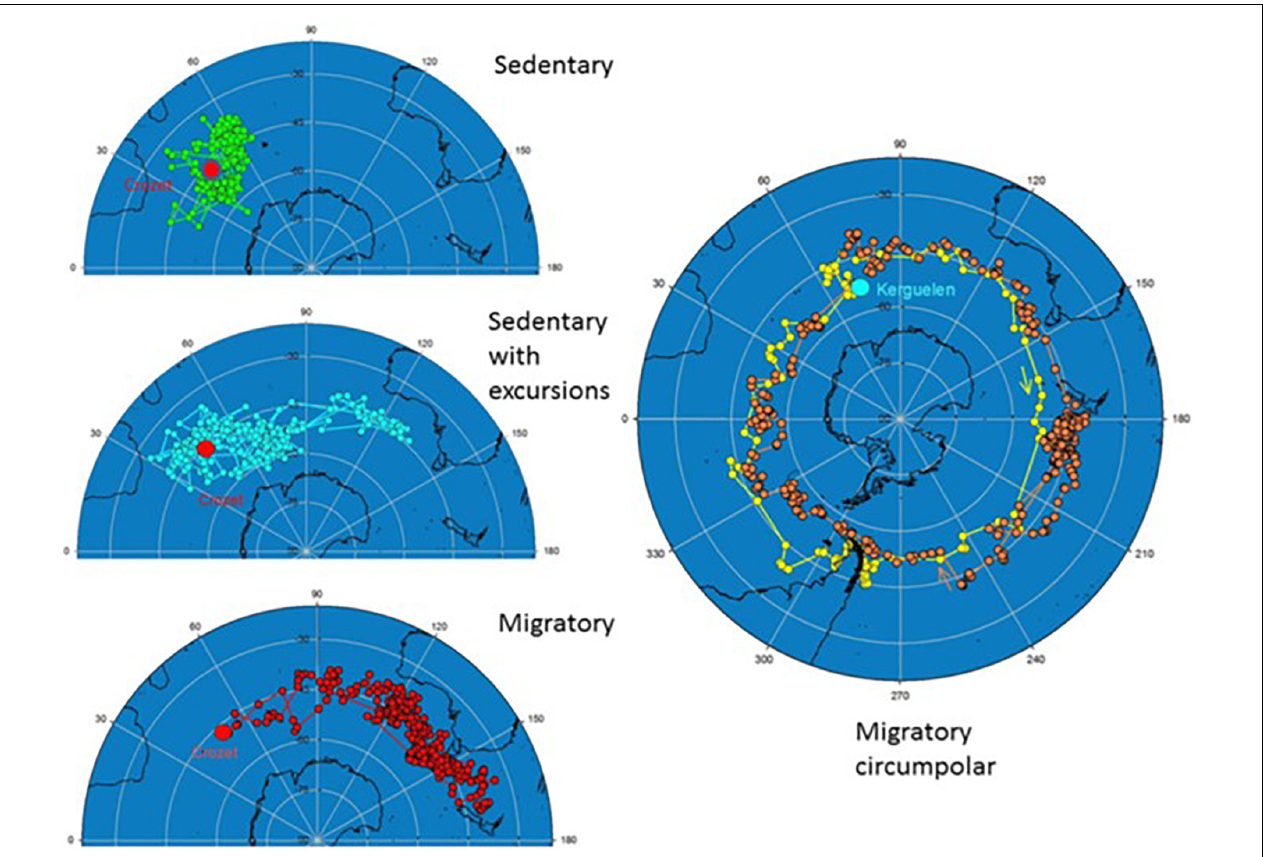
FIGURE 11 | Example tracks for adult Wandering Albatrosses recorded during sabbatical years representing the main movement strategies for birds breeding at Crozet and Kergulean Islands. Movement strategies are sedentary, sedentary with distant excursions of two Crozet birds, and migratory. The full cycle shows extremely long distance migration including two consecutive circumpolar movements of an adult from Kergulean Islands. After an initial rapid flight to Chilean waters where the bird spent 2 months, it moved eastward through the Atlantic and the Indian Ocean (yellow) to reach the Chatham Rise, east of New Zealand, before returning to Kerguelen (orange) through the Pacific and Atlantic. Figures from Weimerskirch et al. (2015), reprinted by permission from Springer Nature//Palgrave.